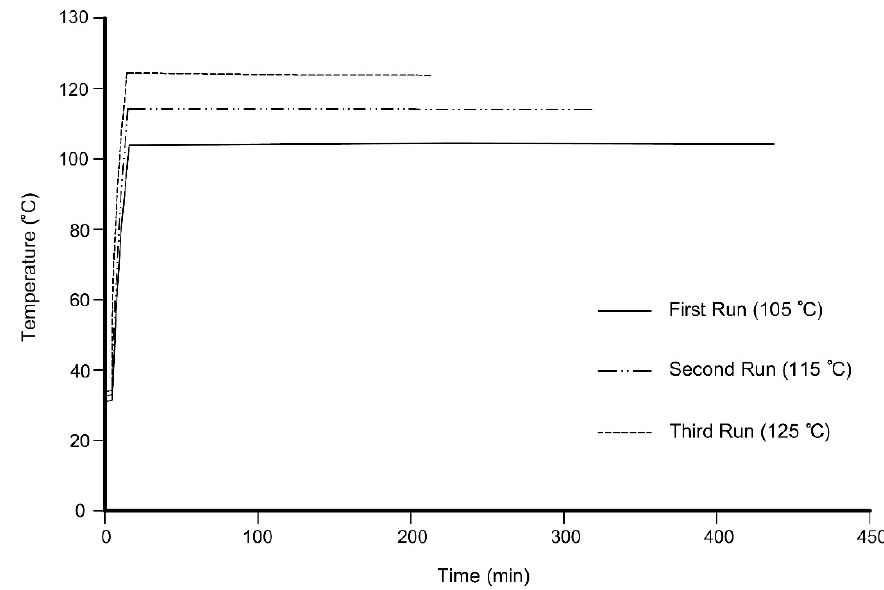
Figure 5. Temperature profiles for the first, second, and third run of wood drying.